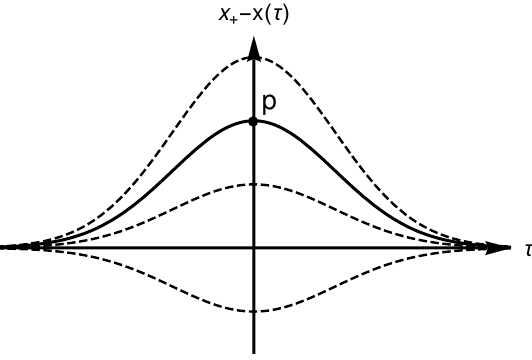
Figure 4 . A series of symmetric quantum paths from x + to itself: ^ x ( (cid:28) ; (cid:26) ), parameterized by (cid:26) . We take the (cid:28) -axis | the trivial false-vacuum solution | as the base point ^ x ( (cid:28) ; 0). The path with its maximum marked by p , indicating the turning point, is the bounce ^ x ( (cid:28) ; b ), for some number b . The paths above the bounce ^ x ( (cid:28) ; (cid:26) > b ) are the quantum paths with escape point beyond